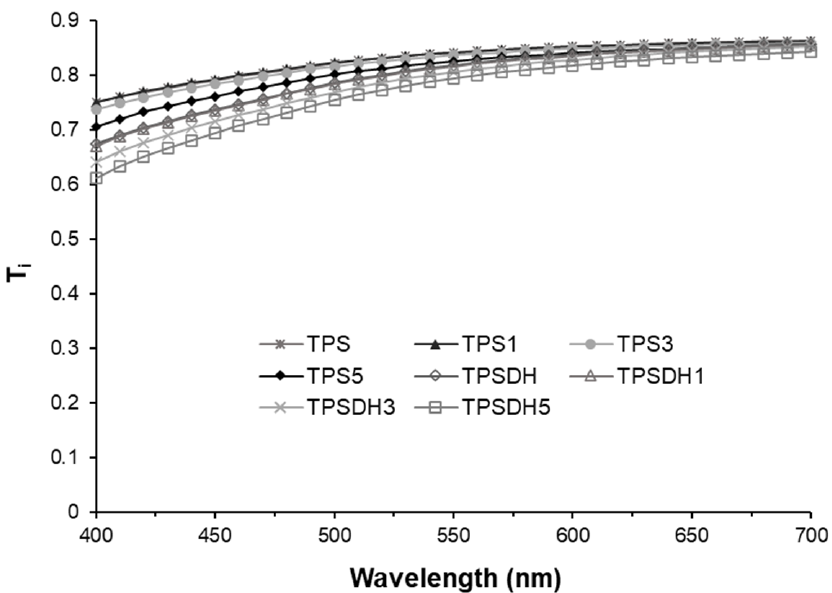
Figure 5. Internal transmittance ( T i ) of thermoplastic starch (TPS) and TPS modified by dry heating (TPSDH) films with different contents of cellulose microfibers (CMFs).